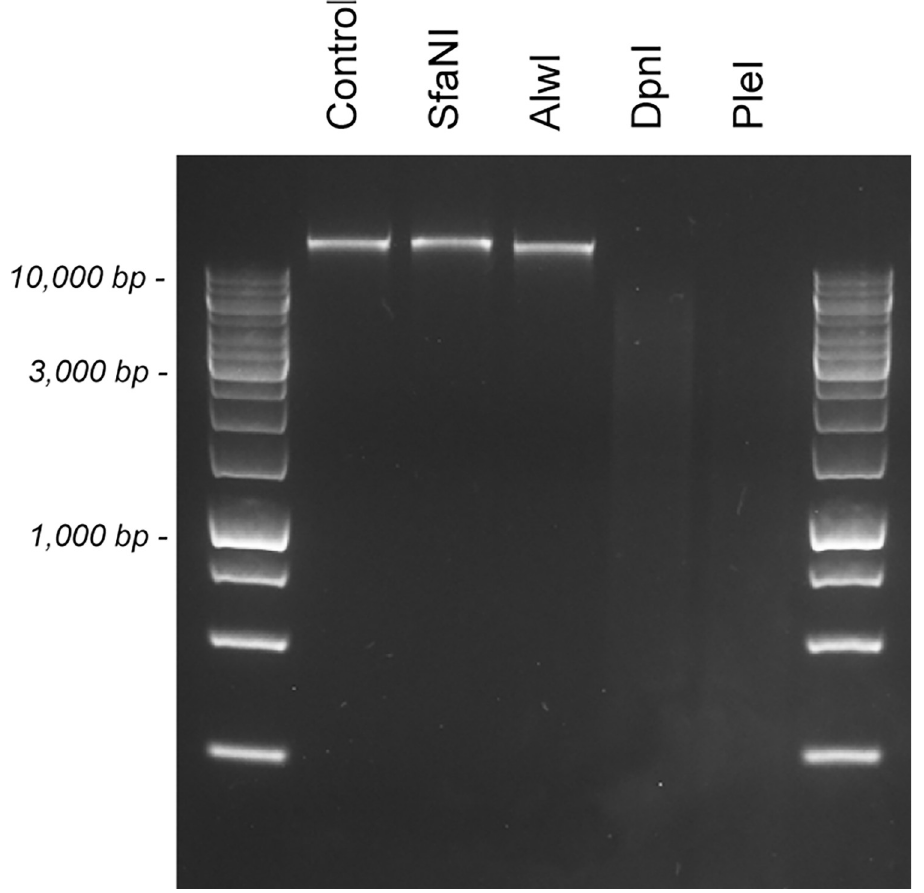
Fig 2. Digestion of genomic DNA of strain BluCon085 with methylation-sensitive restriction endonucleases. Restriction digests were performed by incubating genomic DNA in the presence of the restriction endonuclease SfaNI, AlwI, DpnI or PleI. A restriction digest without restriction endonuclease was included as control.